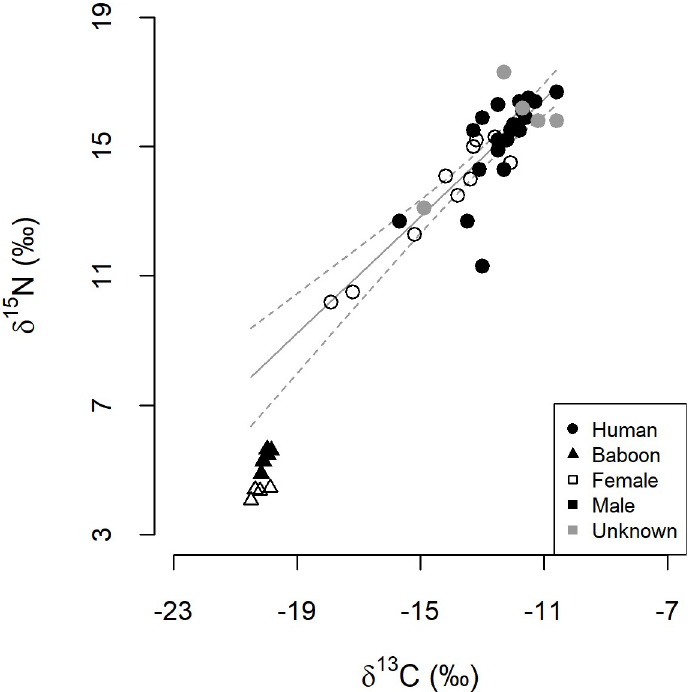
Fig 3. Isotope ratios of Later Stone Age human bone samples and modern baboon hair samples. Symbols denote species and sex as stated in the legend. The solid line depicts the relationship between human δ 13 C and δ 15 N values, described by δ 15 N = 0.9 × δ 13 C + 26.4 (dashed lines indicate 95% confidence intervals). The lines are extended beyond the range of human values to show how baboon values relate to the output from the regression analysis.